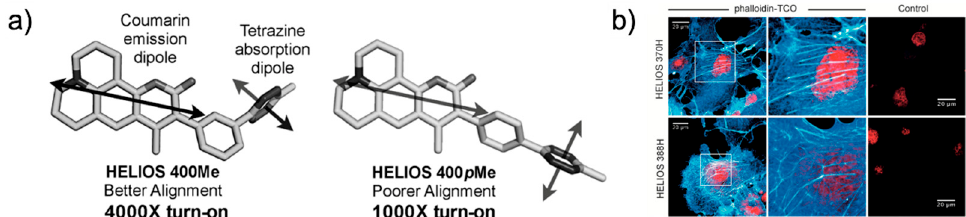
Figure 5. Coumarin-tetrazine probes for fluorogenic imaging. ( a ) Schematic representation of the orientation of the transition dipole between coumarin and tetrazine. ( b ) No-wash, bio-orthogonal fluorogenic imaging of actin filament with phalloidin-TCO. COS-1 cells were sequentially incubated with phalloidin-TCO and DRAQ5. After brief rinsing, cells were imaged upon the addition of the coumarin–tetrazine probe. Reproduced from [42] with permission from